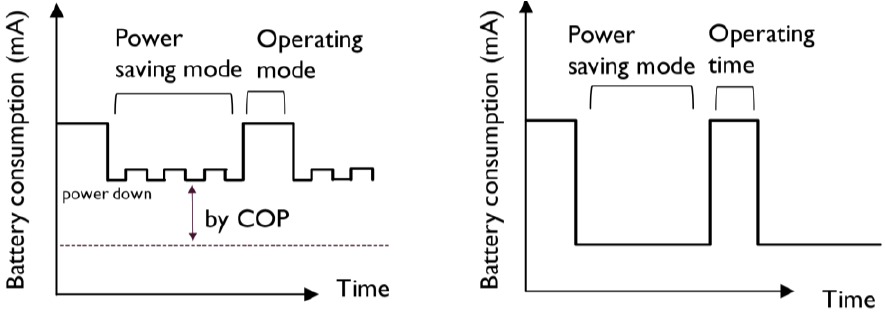
Figure 6. Battery consumption of operating mode and power-saving mode. The UWLD system with sleep mode by the COP timer ( left ) and an ideal power-saving mode ( right ).